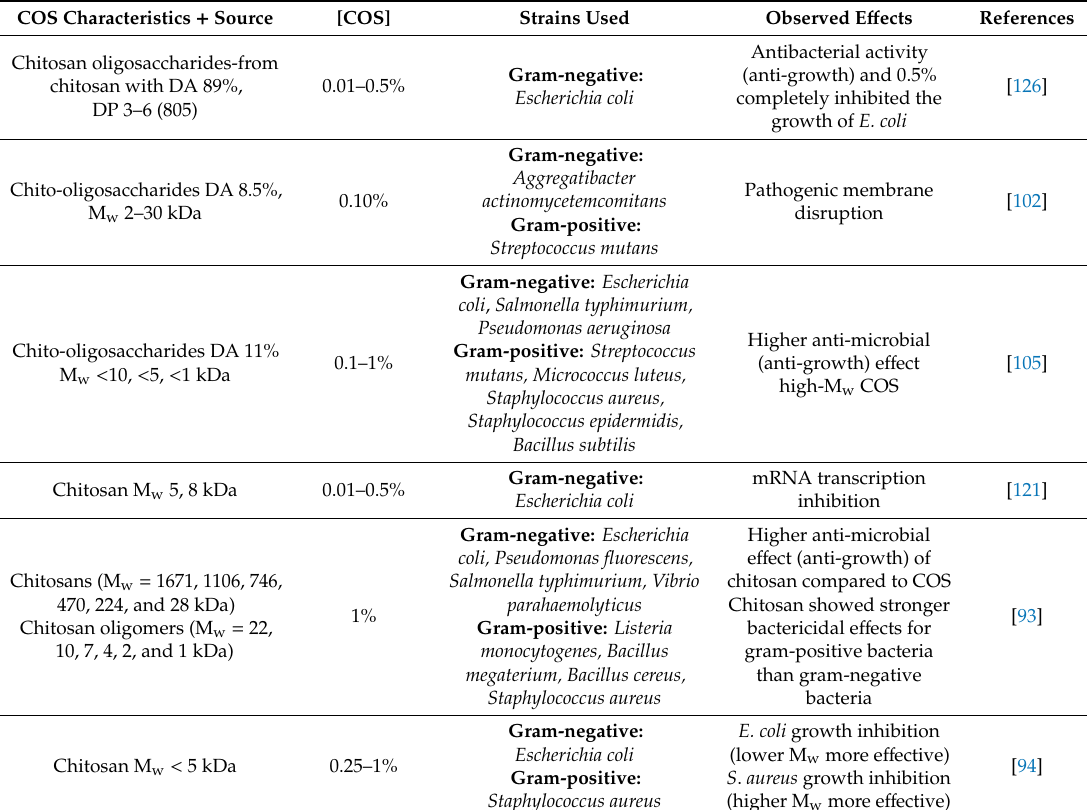
Table 4. Overview of the anti-pathogenic functionalities of